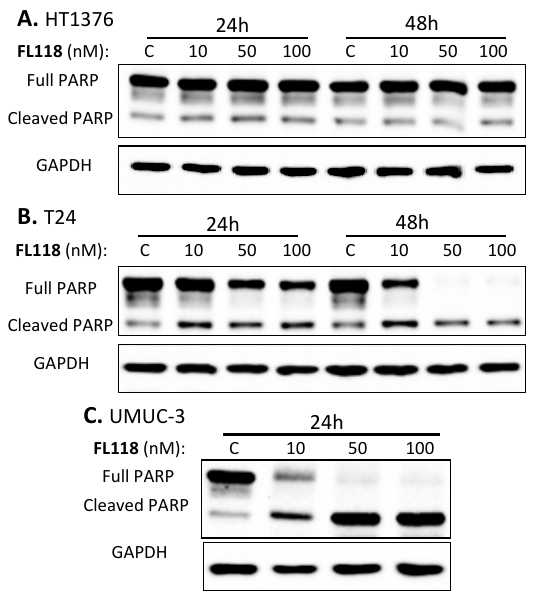
Figure 2. Induction of differential poly (ADP-ribose) polymerase (PARP) cleavage in bladder cancer